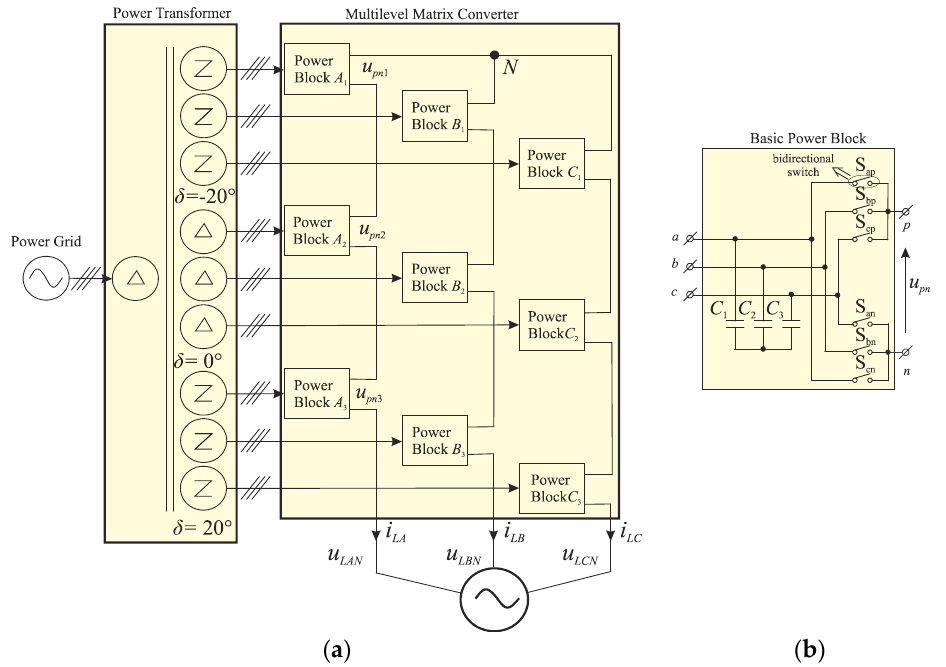
Figure 14. Multilevel, medium voltage matrix converters: ( a ) a multilevel MC with nine basic power switch blocks; ( b ) a three-phase to single-phase (3 × 2) MC power block.